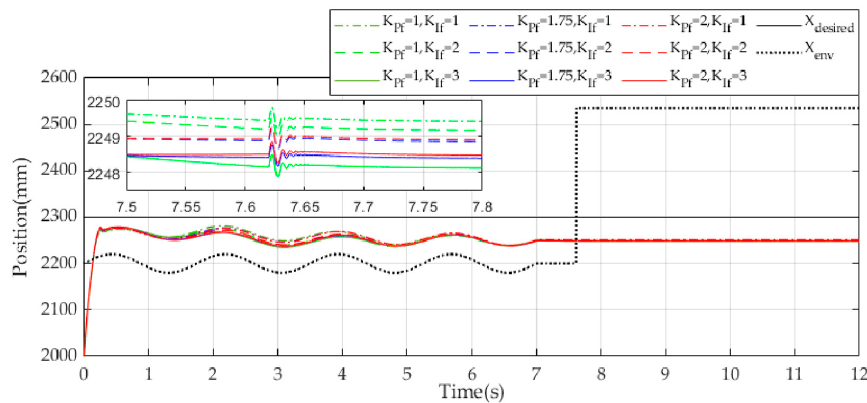
Figure 11. Response of the end-effector in the X-direction under different force control gains.